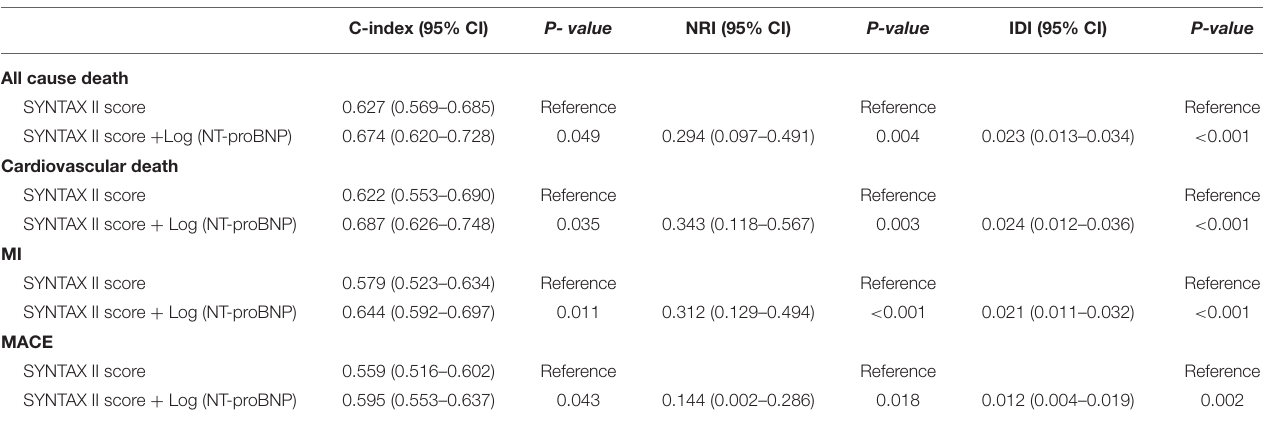
TABLE 5 | Prognostic information provided by NT-proBNP beyond SYNTAX II